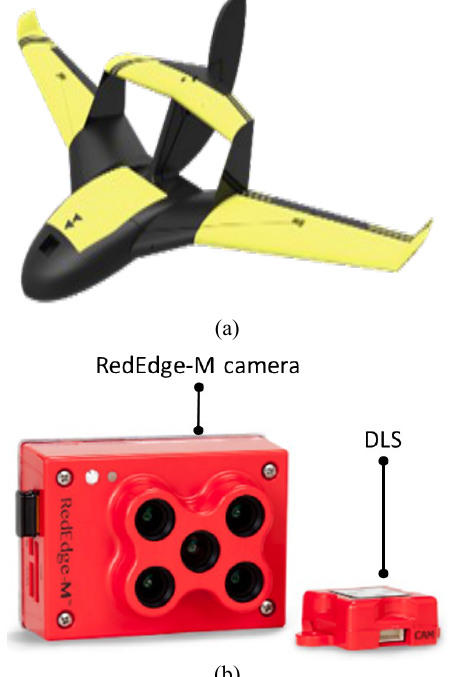
Figure 2. (a) The KD-2 fixed-wing UAV, and (b) the multispectral camera and irradiance sensor